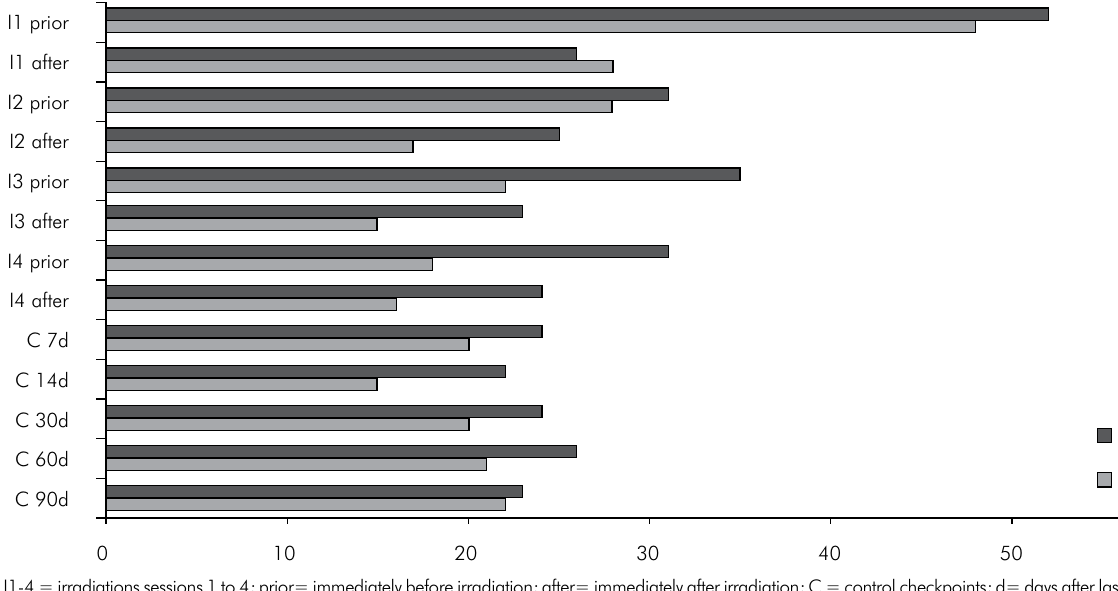
I1-4 = irradiations sessions 1 to 4; prior= immediately before irradiation; after= immediately after irradiation; C = control checkpoints; d= days after last Figure 2. Mean VAS values of both groups (LG, CG) in all irradiation sessions and control checkpoints.